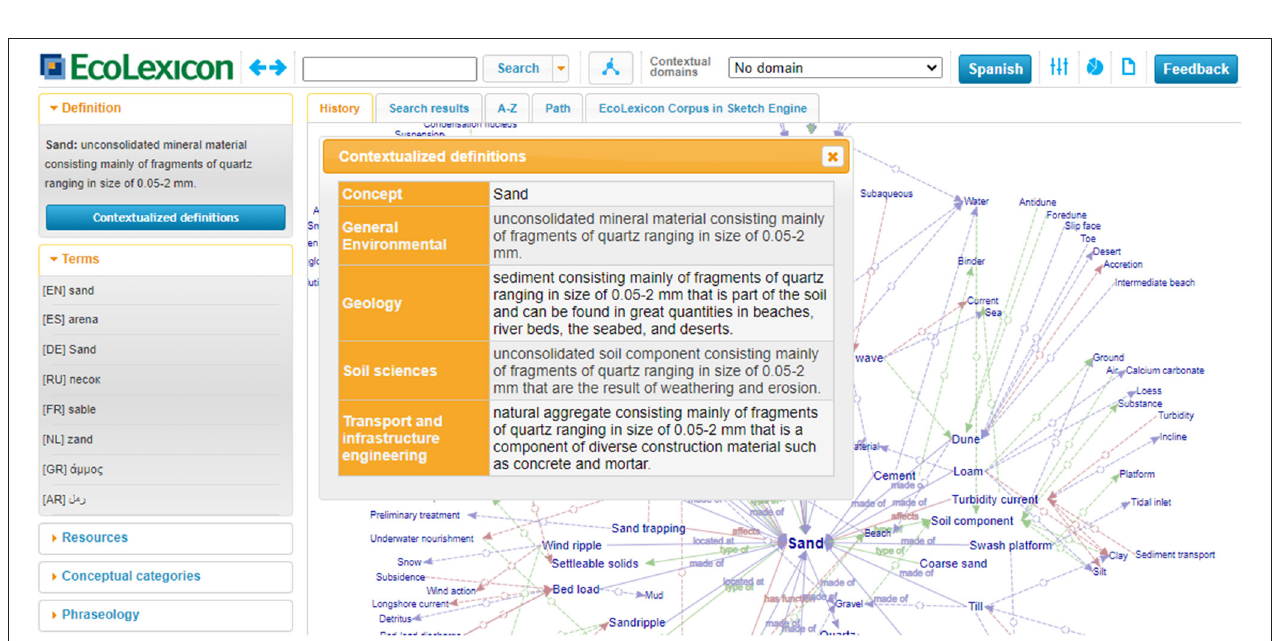
FIGURE 1 | Types of context and the contextual constraints in terminological definitions.